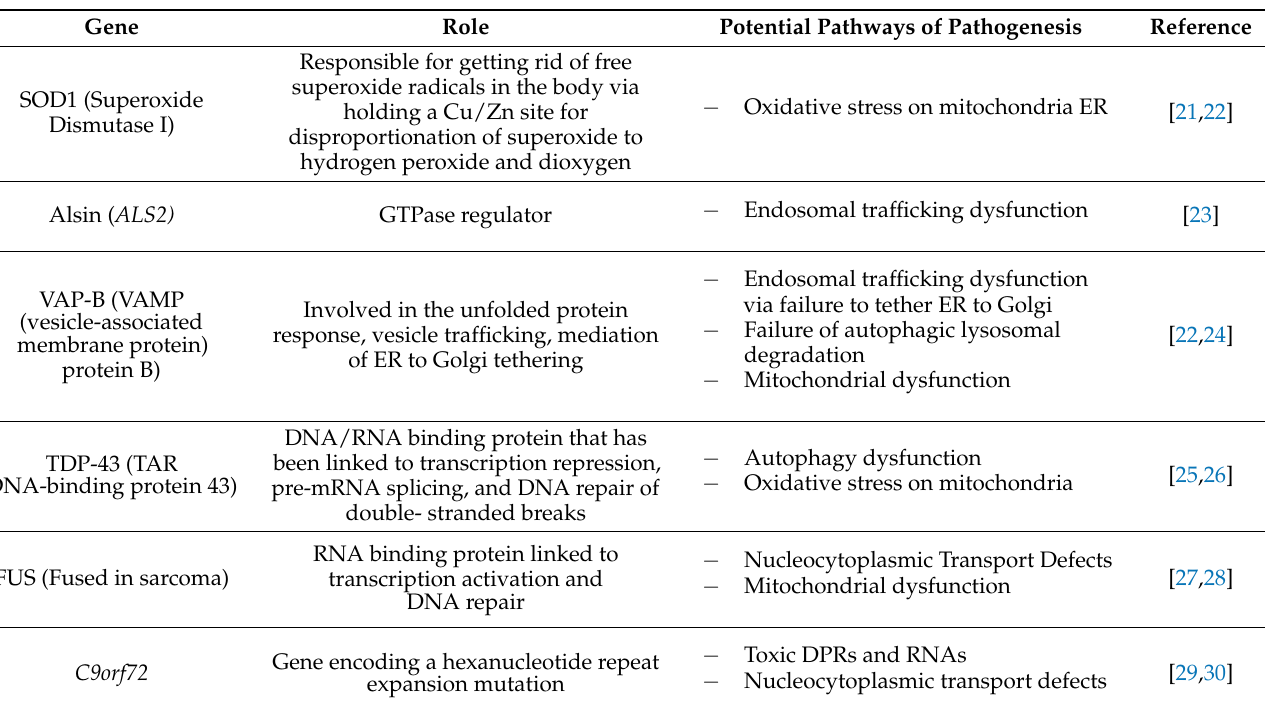
Table 3. Common genes linked to ALS